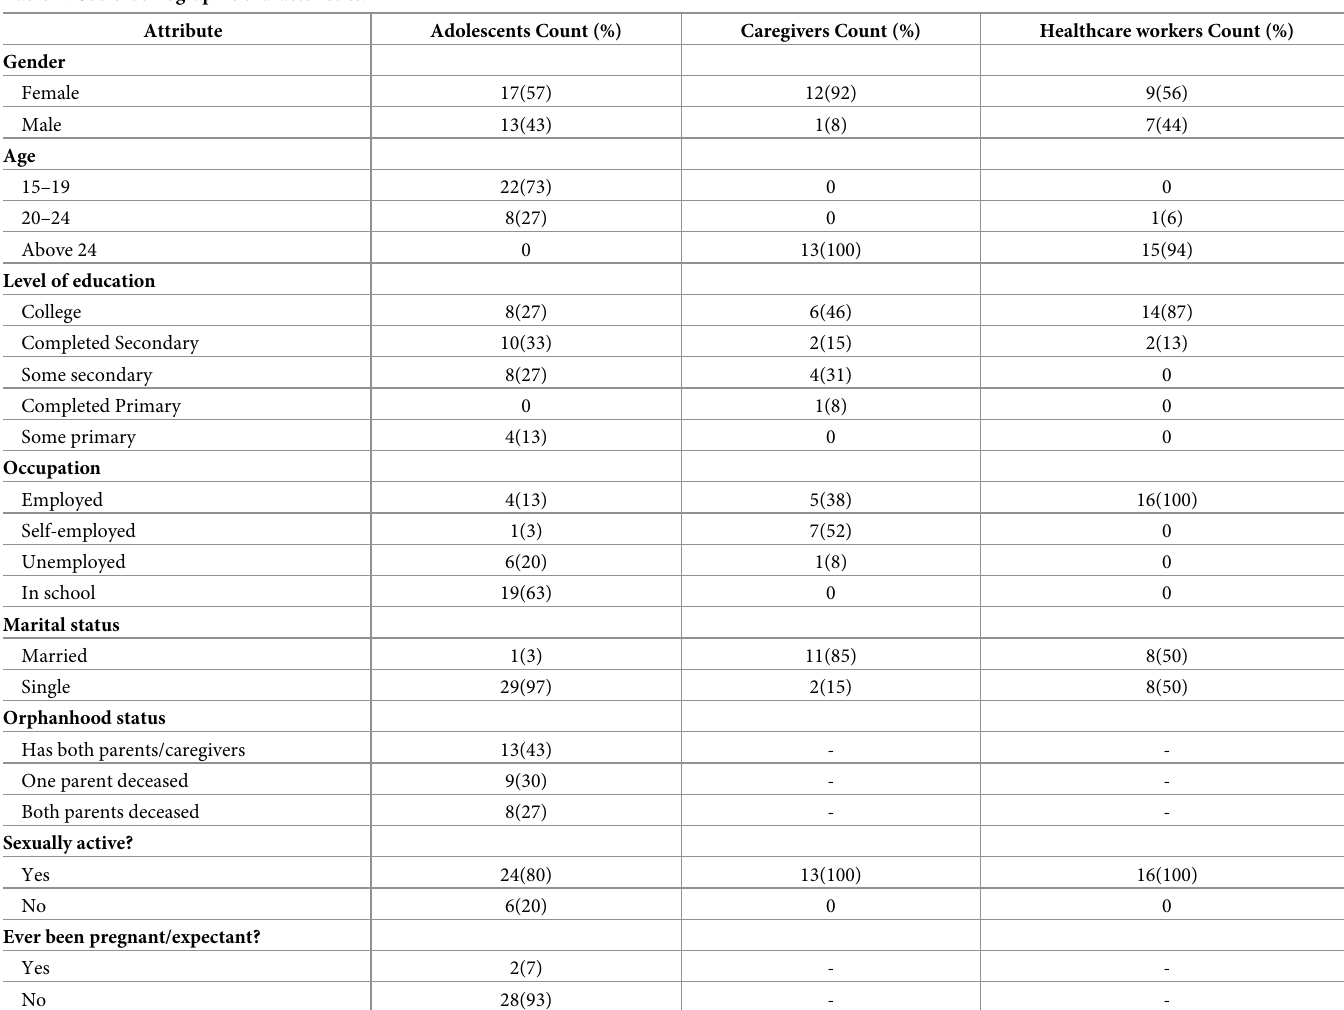
Table 1. Socio-demographic